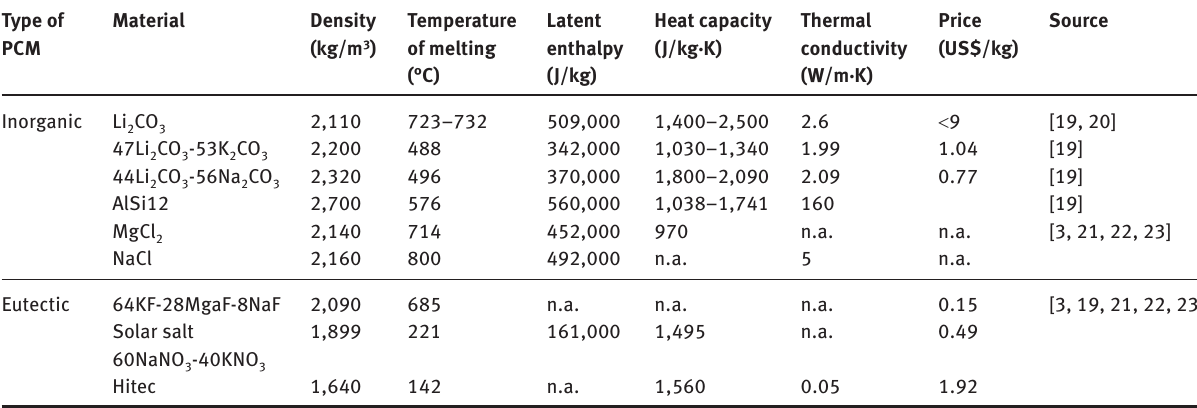
Table 1: Main properties of PCMs retained for the investigation Type of Material PCM